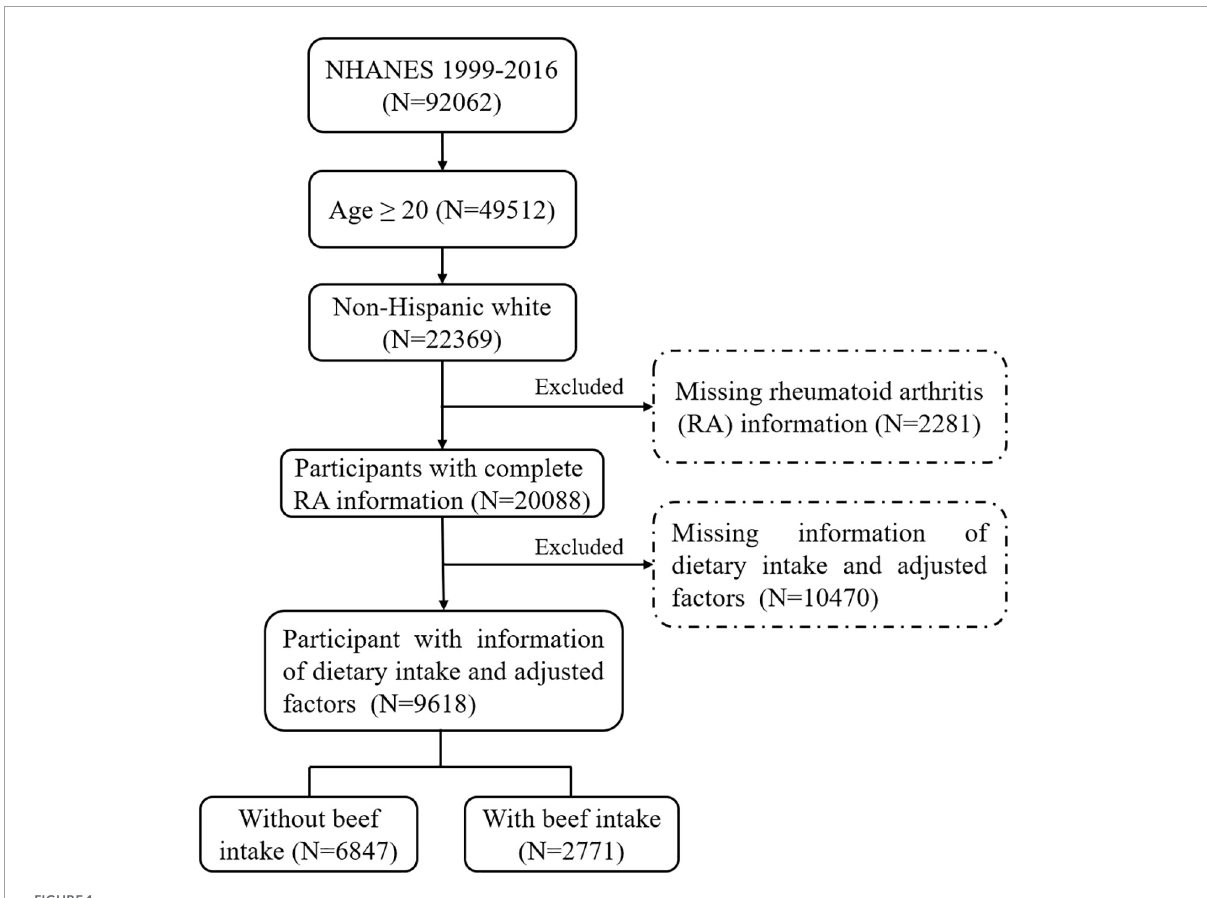
FIGURE1 The flow diagram of participant